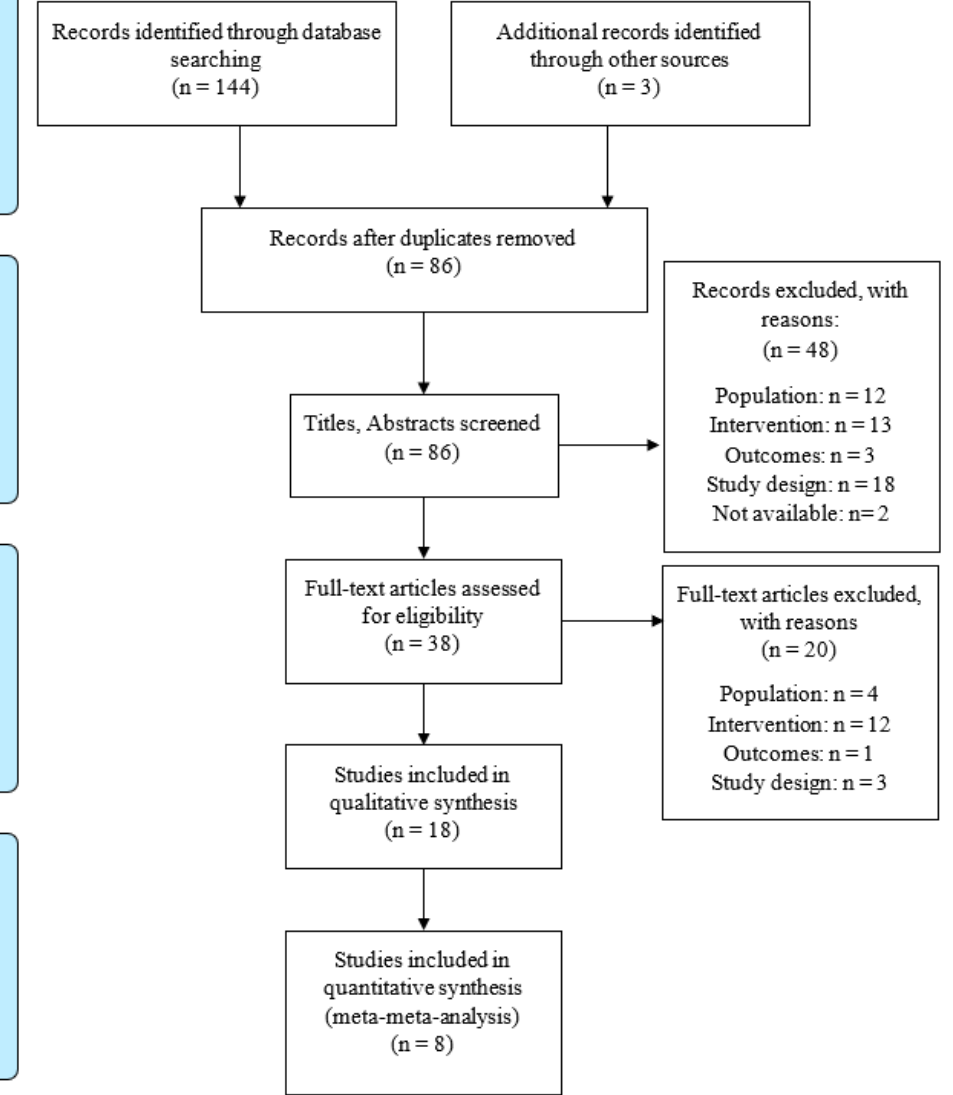
Figure 1. Flow chart according to PRISMA.